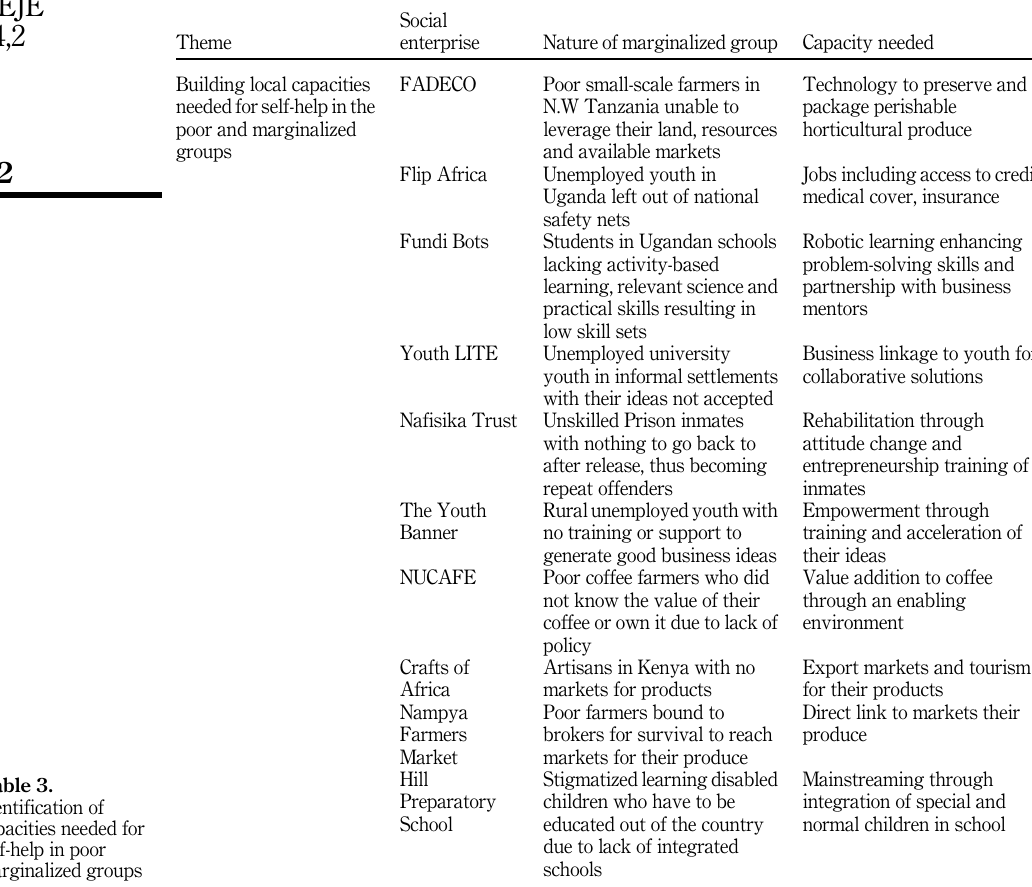
capacities needed for self-help in poor marginalized